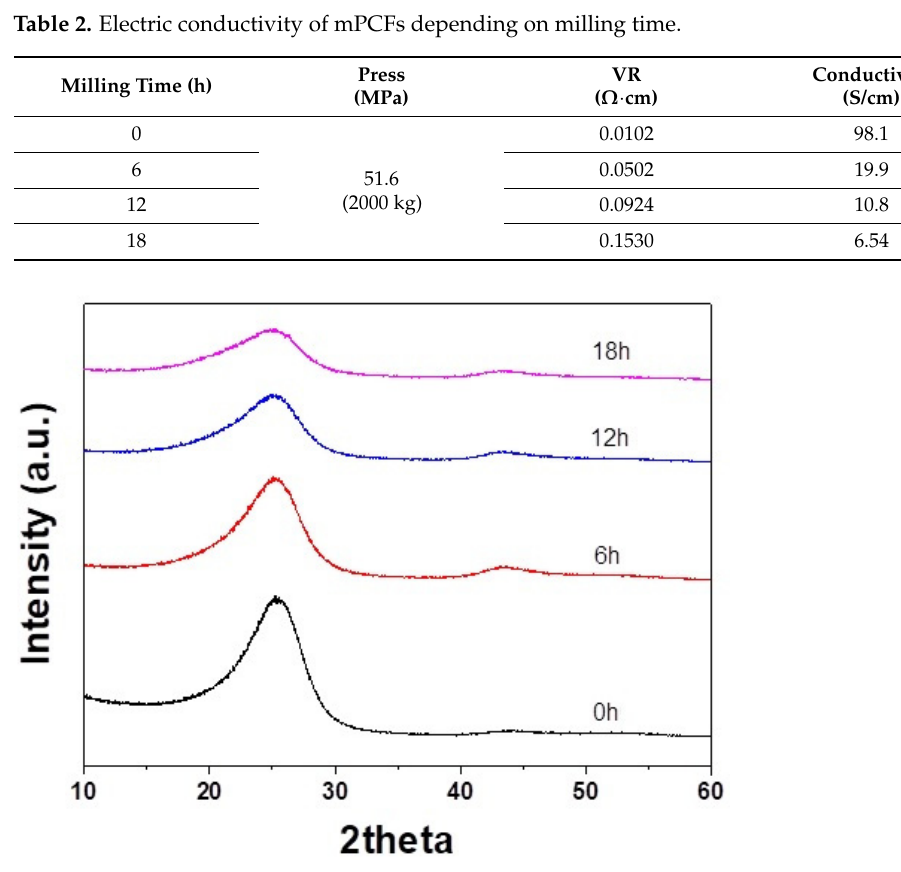
Figure 3. XRD patterns of mPCFs depending on milling time.